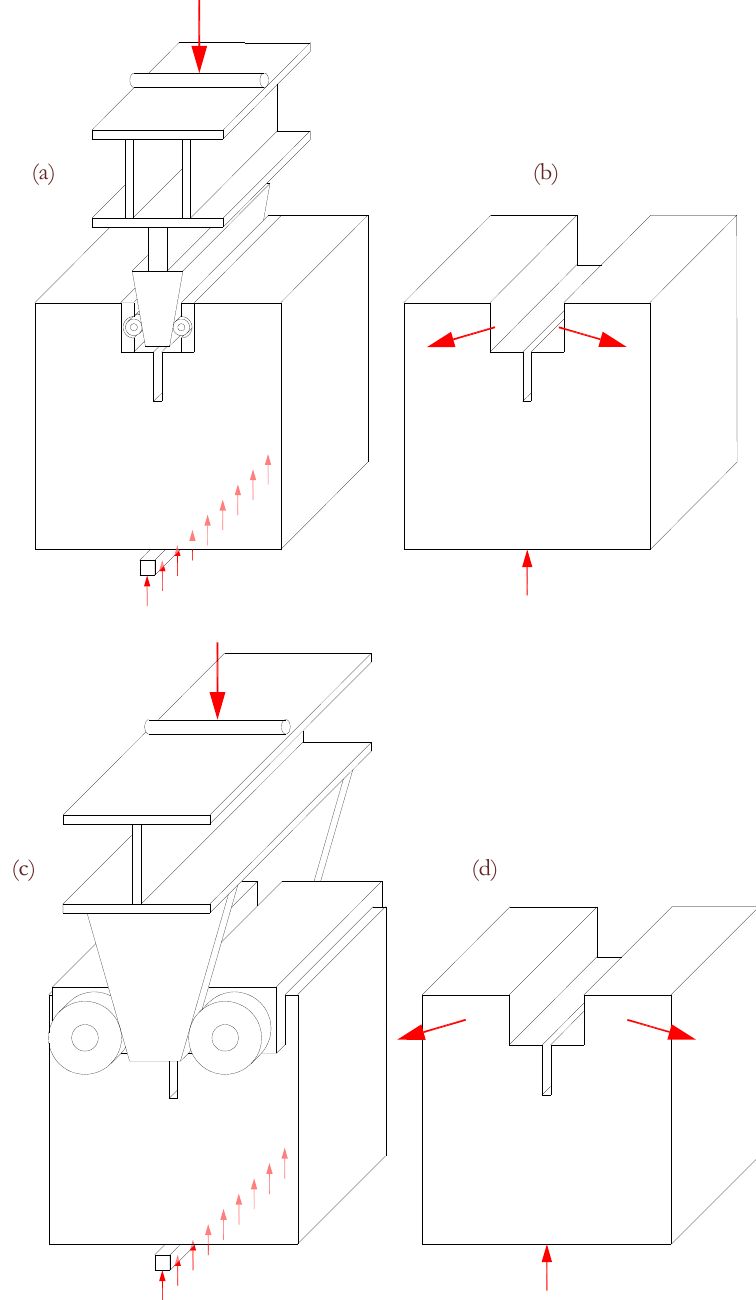
Figure 1: Variants of boundary conditions of the WST geometry in the area of the load application (compare (a), (b) vs. (c),